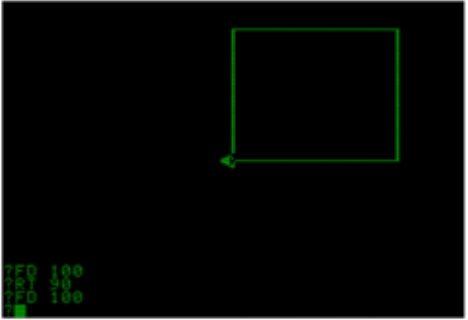
Figure 2 | Drawing shapes by navigating a turtle in